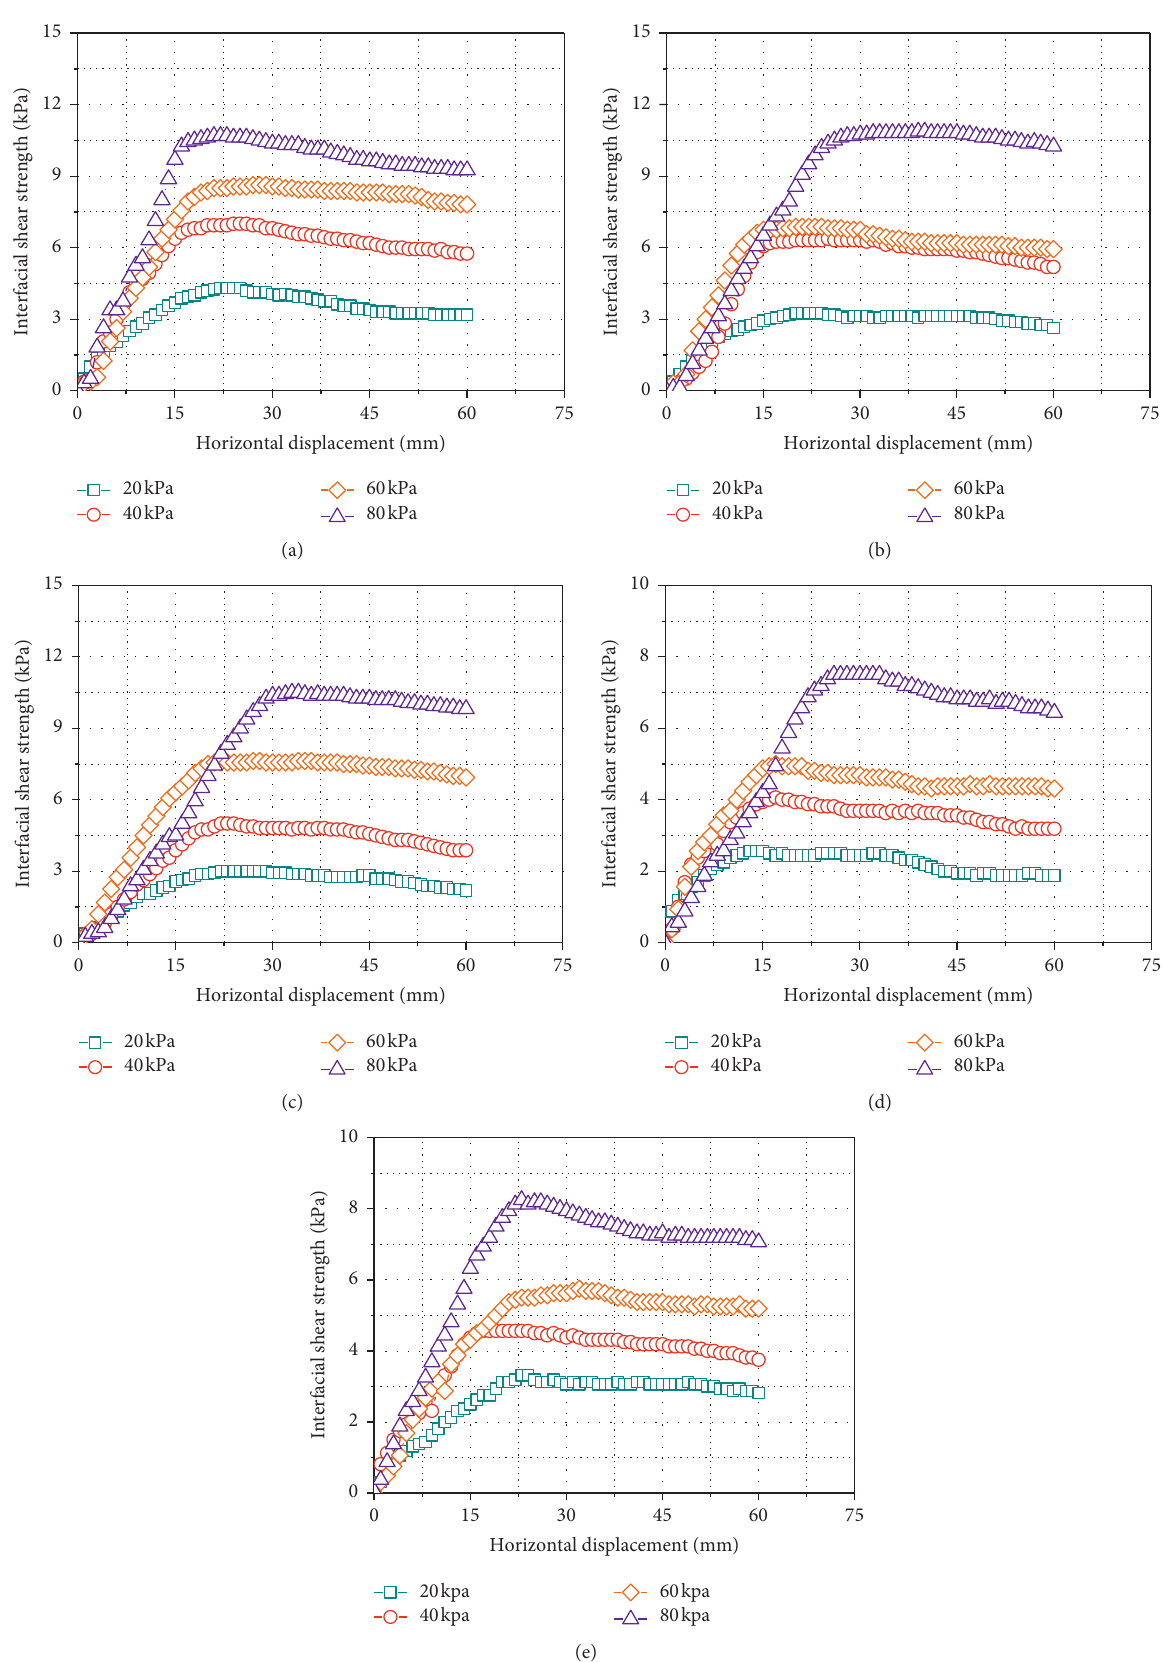
Figure 5: Curve of interface shear strength with horizontal displacement under different normal stress. (a) 5 d, (b) 10d, (c) 20d, (d) 40d, and (e) 60